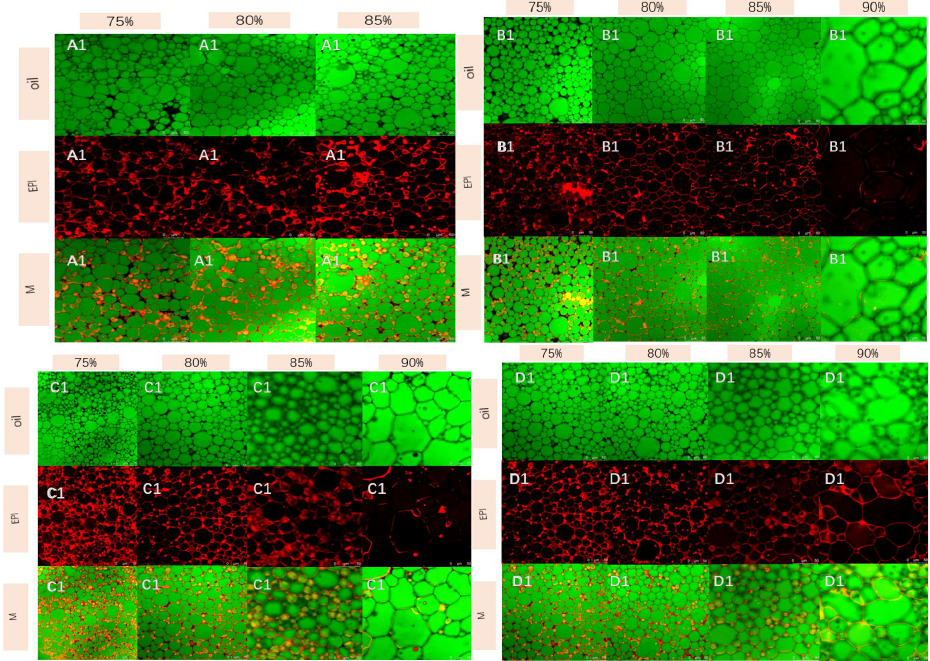
Figure 5. Confocal laser images (CLSM) of groups under different oil phase concentrations (75%, 80%, 85%, 90%) ( A1 : S0, B1 : S1, C1 : S2, D1 :